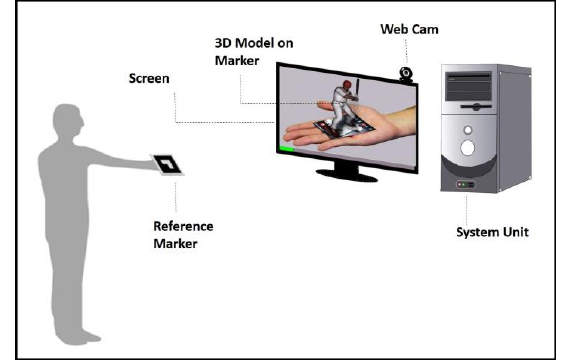
Figure 2. Initial Screen Flaras